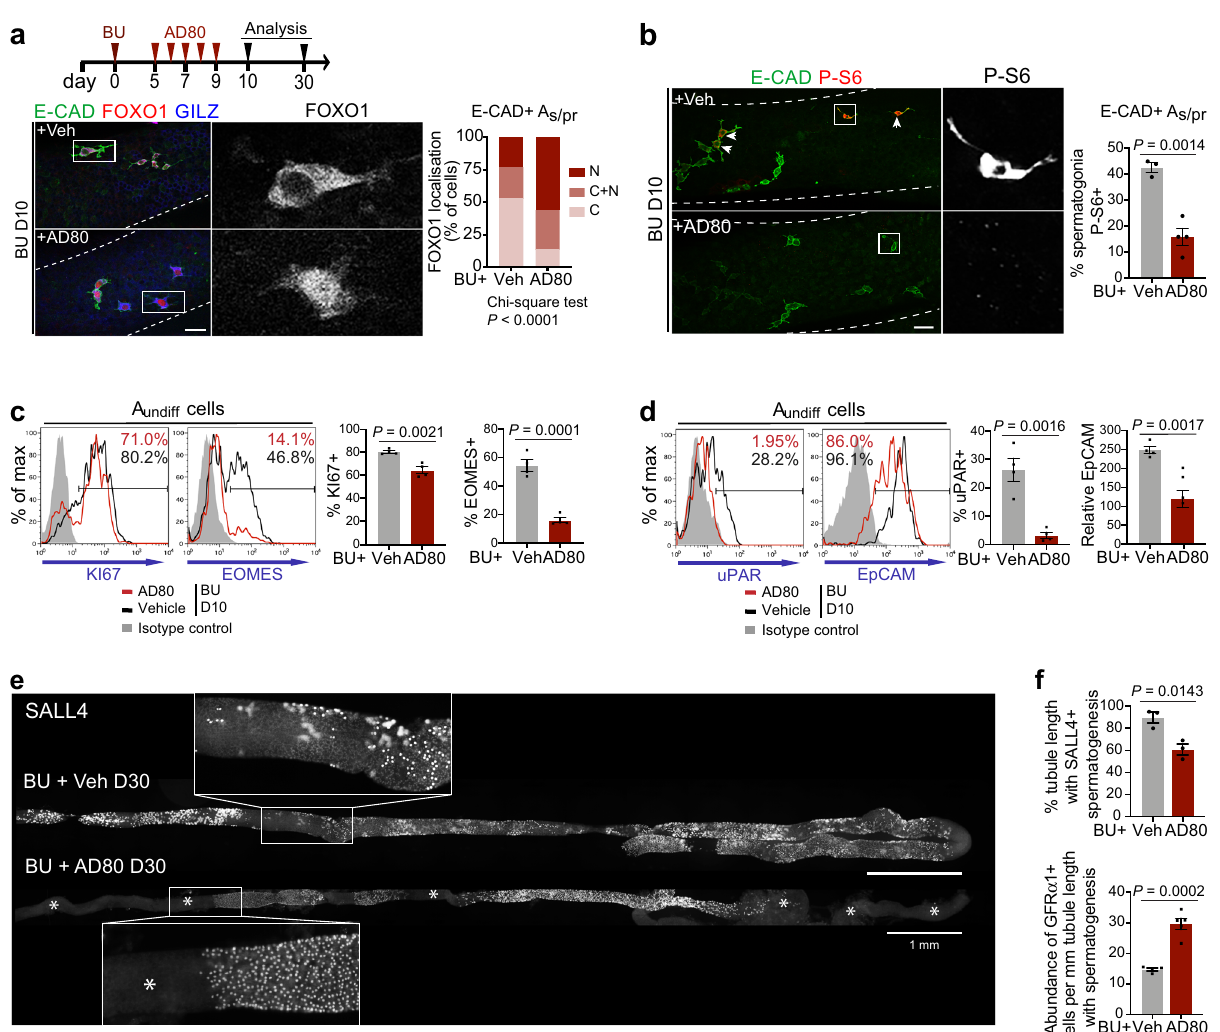
Fig. 5 Molecular features and function of regenerative A undiff are dependent on growth factor signalling. a Upper panel: treatment regimen and analysis timeline for mice receiving multikinase inhibitor AD80 after BU. Lower panels: Representative wholemount IF of adult mice treated with BU then AD80 or vehicle daily for 5 days from D5 post-BU. Higher magni fi cation grayscale images illustrating FOXO1 localisation in highlighted cells are shown. Graph shows FOXO1 distribution within E-CADHERIN + A s /A pr at D10 (N, predominantly nuclear; N + C, nuclear and cytosolic; C, predominantly cytosolic) and P -value ( χ 2 test, two-sided) ( n = 3 vehicle and n = 4 AD80 treated; >100 mm tubule length analysed per sample). b Representative wholemount IF of mice treated as in a . Higher magni fi cation grayscale images of P-S6 in highlighted regions are shown. Graph indicates percentage of E-CADHERIN + A s /A pr P-S6 + at D10 ( n = 3 vehicle and n = 4 AD80). c , d Representative fl ow cytometry of testis from mice treated as in a at D10. Graphs indicate percentage of A undiff (PLZF + c-KIT – ) KI67 + and EOMES + in c and percentage of A undiff (E-Cadherin + c-KIT – ) uPAR + plus relative levels of EpCAM on A undiff (median